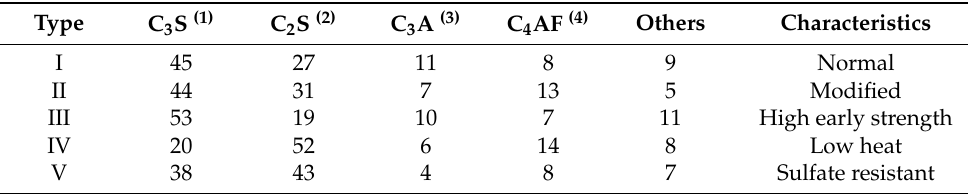
Table 4. Composition (wt%) of Portland cement (KS)